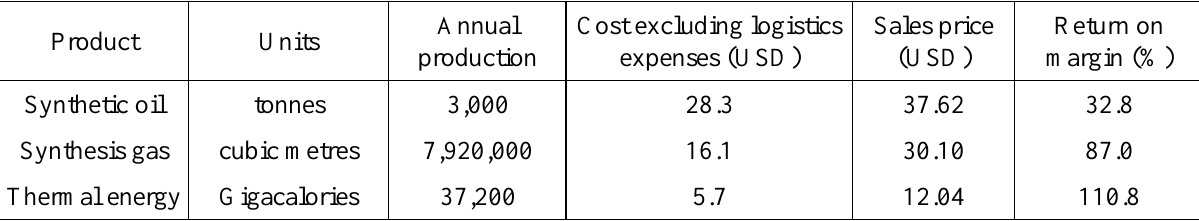
Table 9. Value indicators of the final by-products of fast pyrolysis of peat.